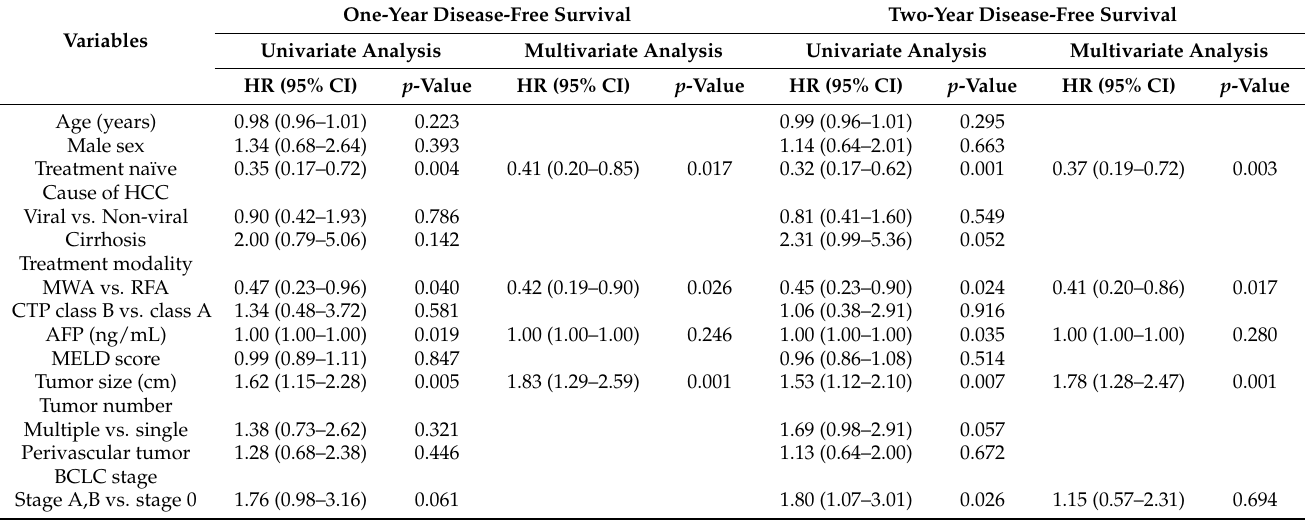
Table 3. Univariate and multivariate Cox regression analysis for disease-free